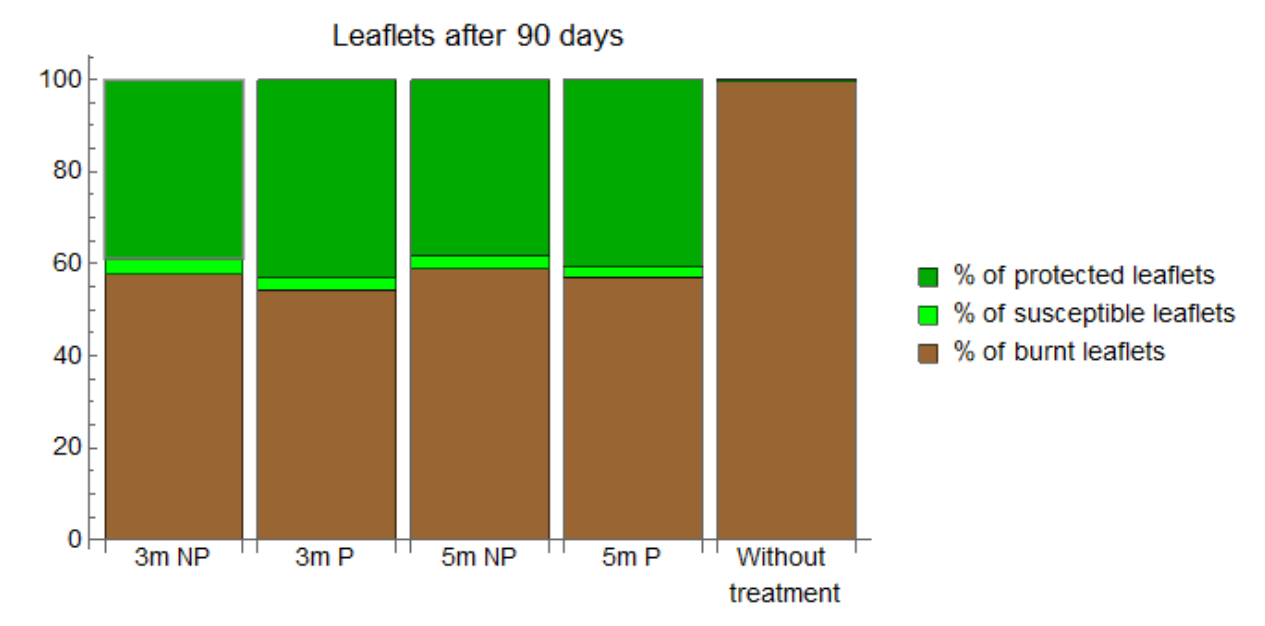
Figure 4. Percentage of burnt (brown), susceptible (light green), and protected (dark green) leaflets at day 90 after standard cyproconazole application for different methods of application (NP = nonpressurized, P = pressurized) and palm heights (3 m and 5 m).